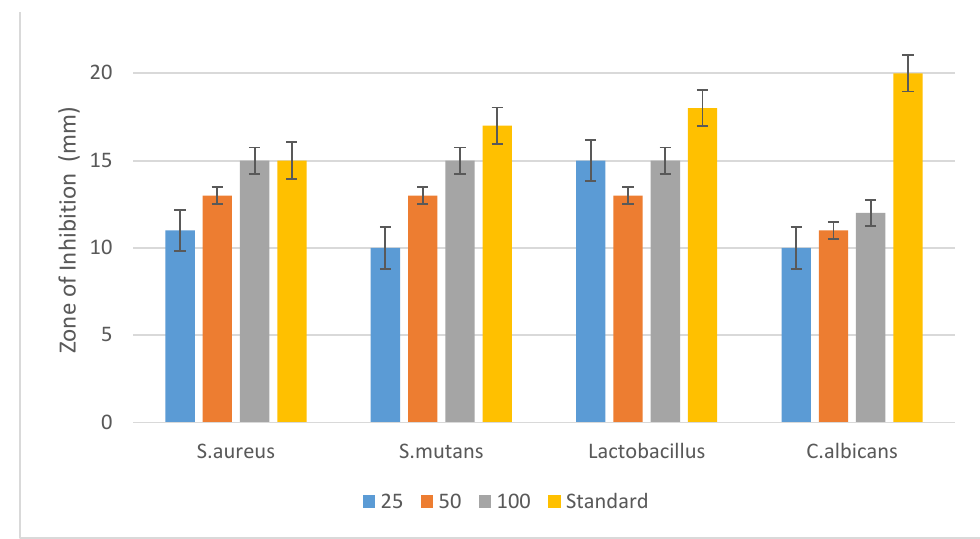
Figure 8. Antimicrobial activity of Ulvan AgNP mouthrinse against oral pathogens.